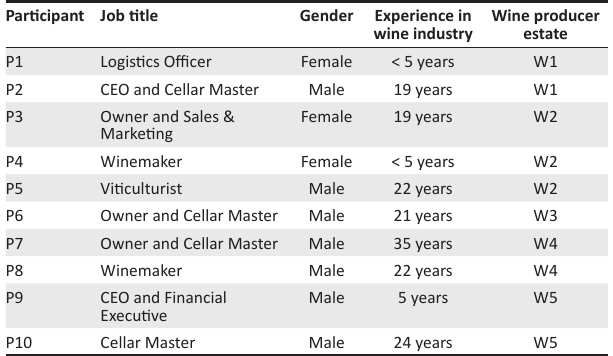
TABLE 1 : List of